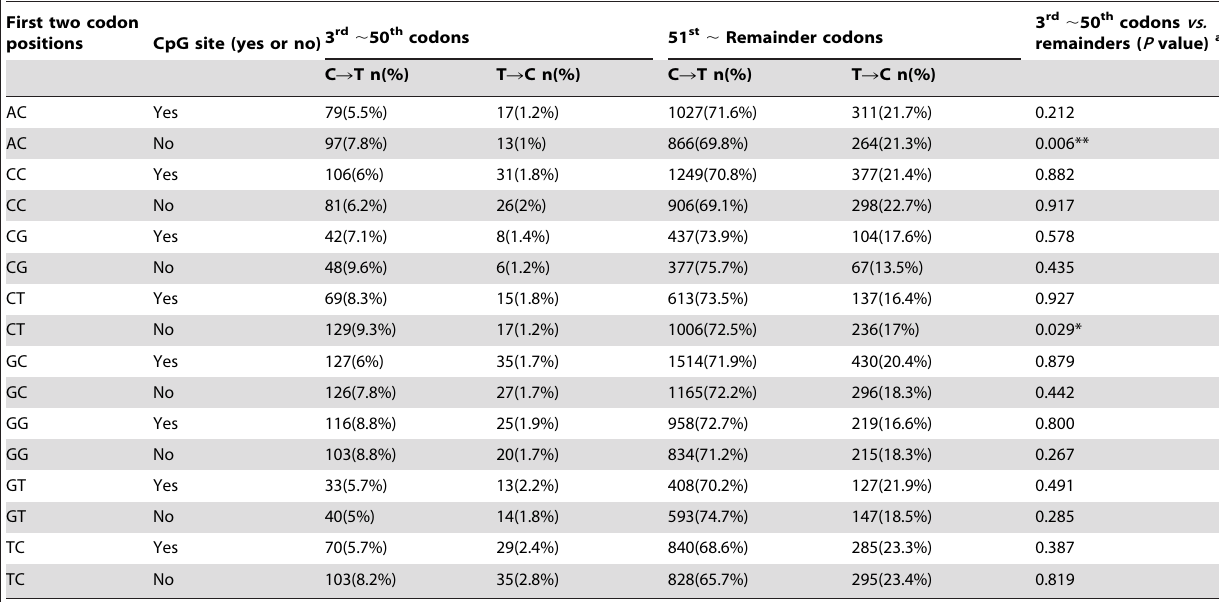
Table 3. C « T fourfold degenerate site